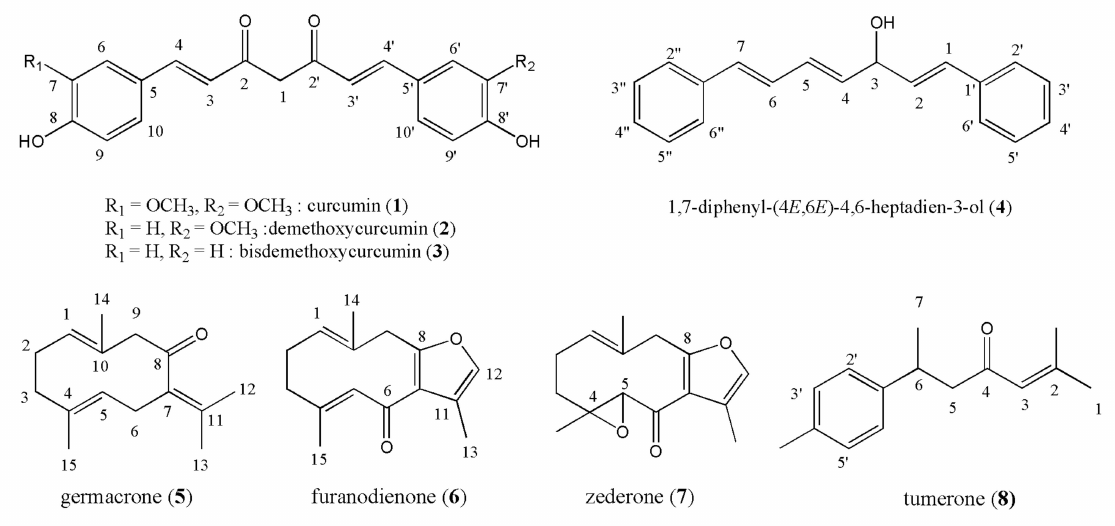
Figure 1. Structure of curcuminoids and sesquiterpenoids isolated from Curcuma